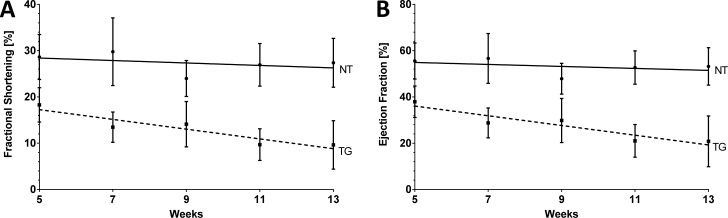
Functional cardiac assessment of transgenic DSC2 mice using 2D echocardiography.Time dependent analysis of LV (A) fractional shortening and (B) ejection fraction of non-transgenic (solid line) and transgenic mice (dotted line). n(NT) = 12 (6 m, 6 f); n(WT) = 12 (6 m, 6 f). One DSC2 transgenic animal died at the age of 12 weeks. Data are presented as mean ± SD.